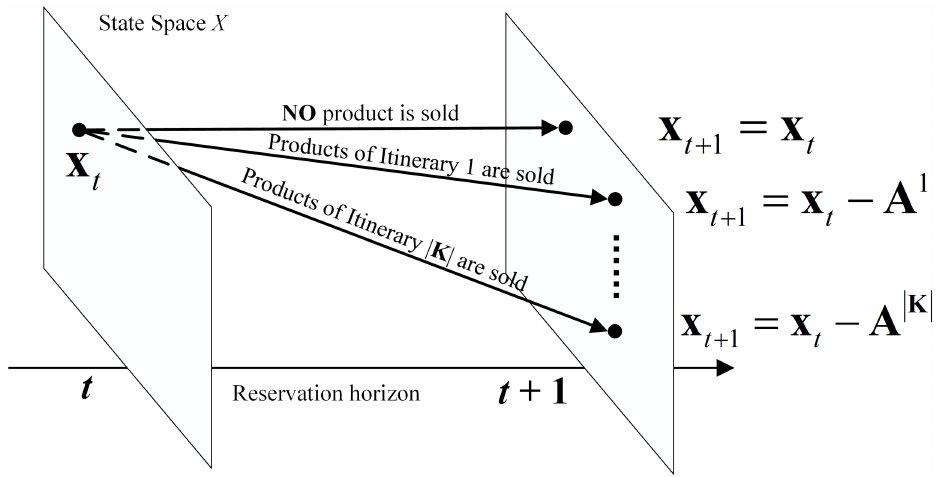
Fig 6. The structure of the DP